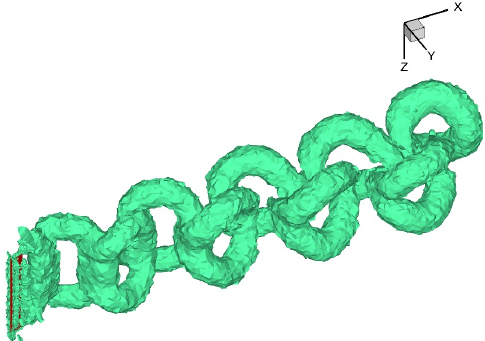
Figure 6. Vortex pattern behind the foil. Table 1. Reference results of flapping foil.